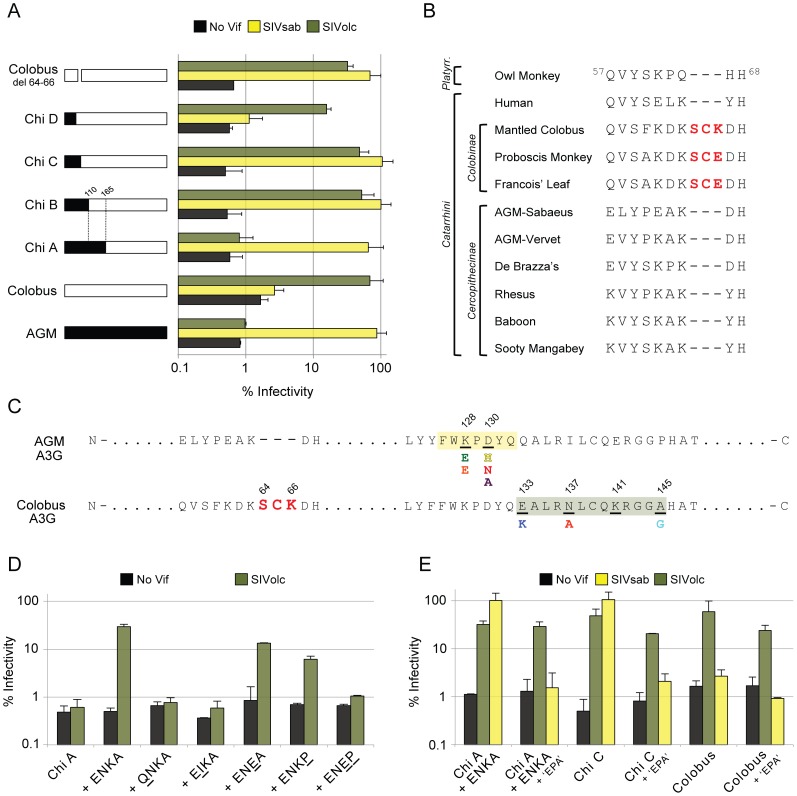
A multi-residue insertion that blocks Vif emerged 12 MYA in A3G of the Colobinae ancestor.(A) Single-round infectivity assays were performed with HIV-1ΔVif and HIV-1 expressing SIV Vif proteins produced in the presence of colobus/AGM chimeric A3G proteins. Infectivity of viruses is reported as a percentage, relative to infectivity in the absence of A3G (100%). Error bars indicate standard deviation from the mean of two independent transfection experiments (six infection replicates in total). (B) Partial protein alignment of A3G orthologs reveals a three-residue insertion (red) unique to members of the Colobinae subfamily of OWM. Members of primate parvorders Catarrhini (Old World Monkeys and Hominoids) and Platyrrhini (New World Monkeys) are included. Old World Monkeys are further divided into subfamilies Cercopithecinae and Colobinae. (C) Residues of A3G responsible for differential sensitivity to SIVsab and SIVolc Vif. The canonical Vif binding site is boxed in yellow. Divergent character states independently selected at residues 128 and 130 (underlined) of Cercopithecinae A3G are displayed below. The three-residue insertion in the N-terminus of colobus A3G is bolded in red. The residues of A3G required for antagonism by SIVolc Vif, as found in this study, are underlined and boxed in green. Divergent character states at residues 133, 137 and 145 identified in Colobinae A3G are displayed below. (D) and (E) Single-round infectivity assays were performed with HIV-1ΔVif and HIV-1 expressing SIVolc Vif produced in the presence of mutated colobus/AGM chimeras.